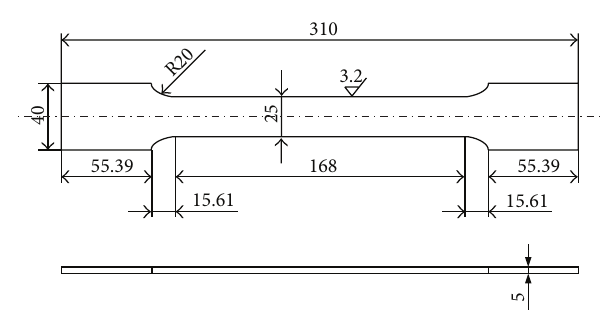
Figure 3: Dimensions of specimens of tensile